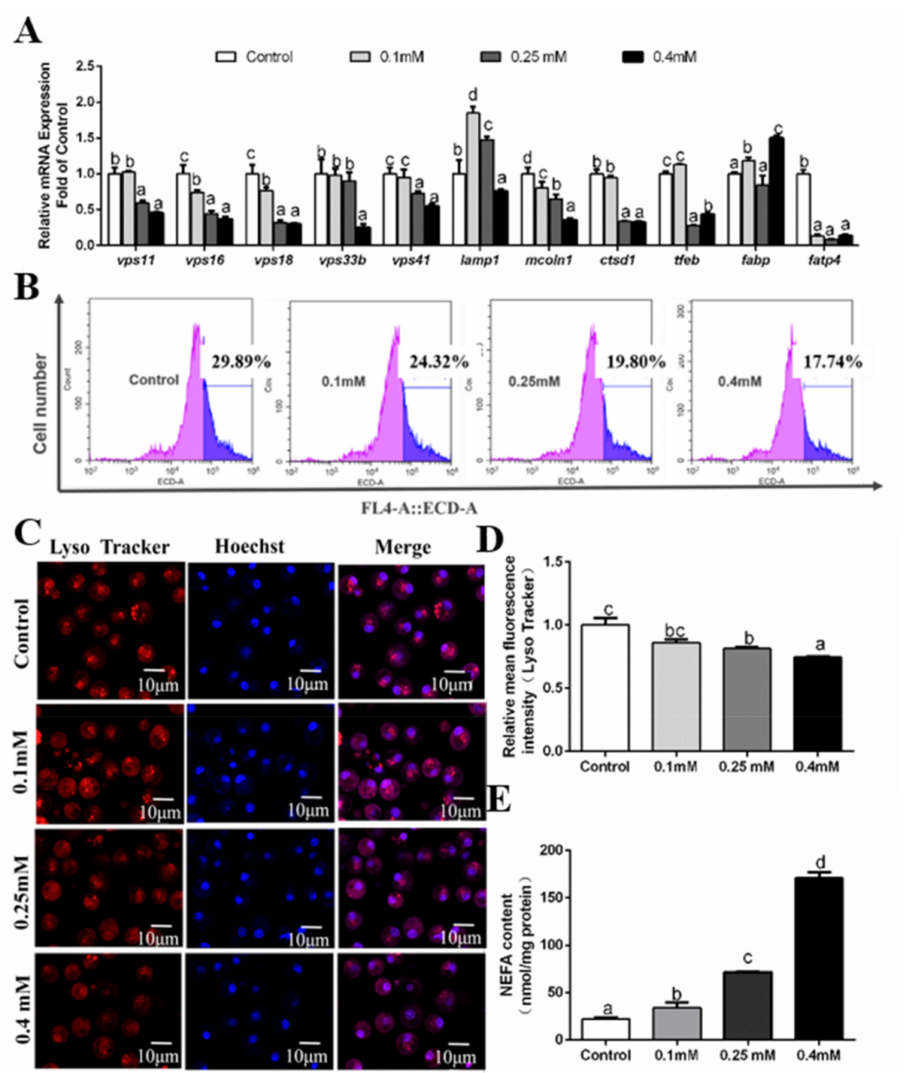
Figure 4. E ff ects of 24 h PA incubation on autophagosomes in hepatocytes of P. fulvidraco. ( A ) E ff ects of 24 h PA incubation on the mRNA levels of autolysosomes related genes; data (mean ± SEM, n = 3) were expressed relative to expression of housekeeping genes ( gapdh and 18s rRNA (M = 0.1887)). ( B ) The e ff ect of 24 h PA incubation on intracelluar autolysosomes demonstrated by flow cytometry analysis of the presence of Lyso Tracker-stained intracellular autolysosomes. ( C ) Representative confocal microscopy image of hepatocytes co-stained with Hoechest (blue) and Lyso Tracker (red) after 2 4h PA incubation. ( D ) The e ff ect of 24 h PA incubation on intracelluar autolysosomes demonstrated by flow cytometric analysis of red (FL4) mean fluorescence intensity. ( E ) E ff ects of 24 h PA incubation on NEFA content. Letters ( a–d ) denote significance, p <